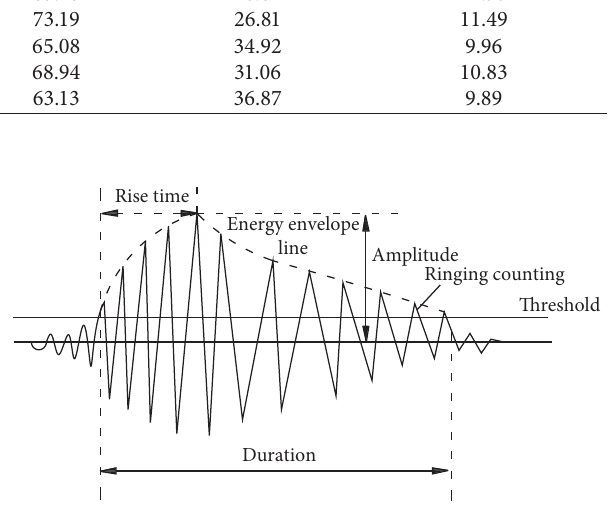
Figure 6: Principle of acoustic emission energy